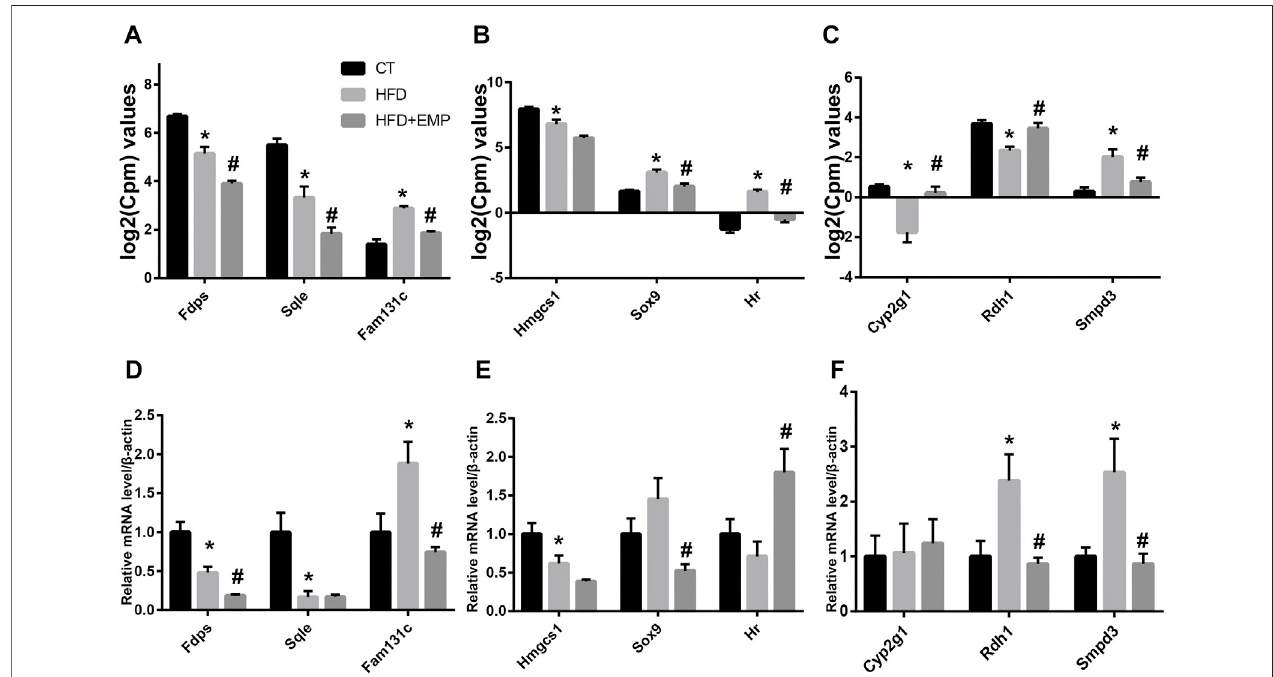
FIGURE 8 | Quantitative real-time PCR validation of RNA-seq analysis of DEGs. Graphs represent log 2 (CPM) values of gene expression levels (A-C) in RNA-seq dataandmRNAlevelsnormalizedto β -actin,* p < 0.05vs.CT,# p < 0.05vs.HFD, n (cid:1) 5, (D-F) fromquantitativereal-timePCRdata.Dataarepresentedasmeans ± SEM, * p < 0.05 vs. CT, # p < 0.05 vs. HFD, n (cid:1) (4 –